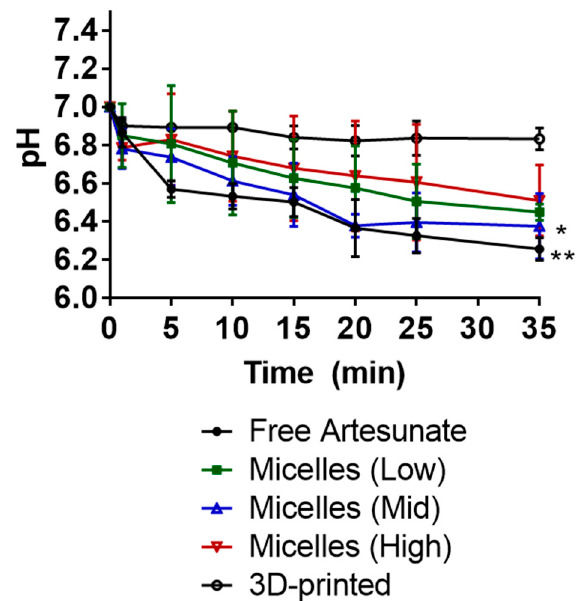
Figure 4. pH change in PBS (pH 7, 37 ◦ C) medium upon drug release in vitro. At 30 min, 3D printed vs. micelles (mid): * p = 0.0256; 3D printed vs. free artesunate: ** p = 0.0063.